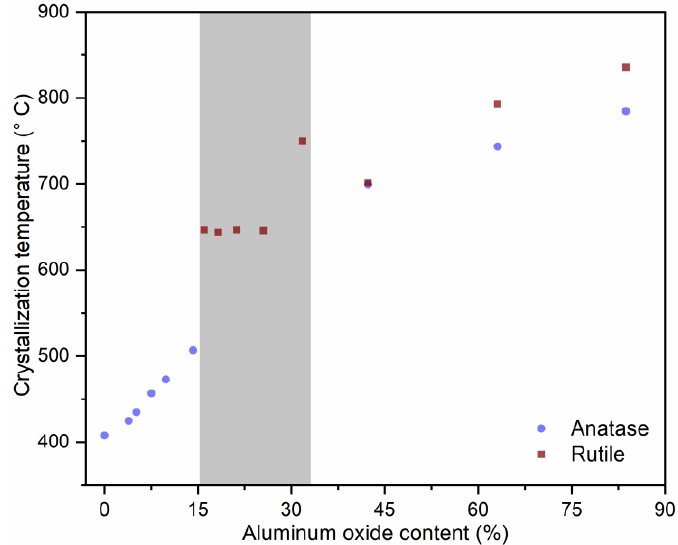
Figure 4. Influence of aluminum oxide content on the crystallization behavior and temperature of titanium dioxide phases, namely anatase and rutile. Data points were extracted from the in situ XRD measurements performed up to 900 ◦ C, shown in Figure 3 and Figure S3. The grey area indicates the region for which the films crystallize directly into rutile phase. Note that after heat treatment at 1200 ◦ C, all films present the rutile phase; see Figure S2 for details.